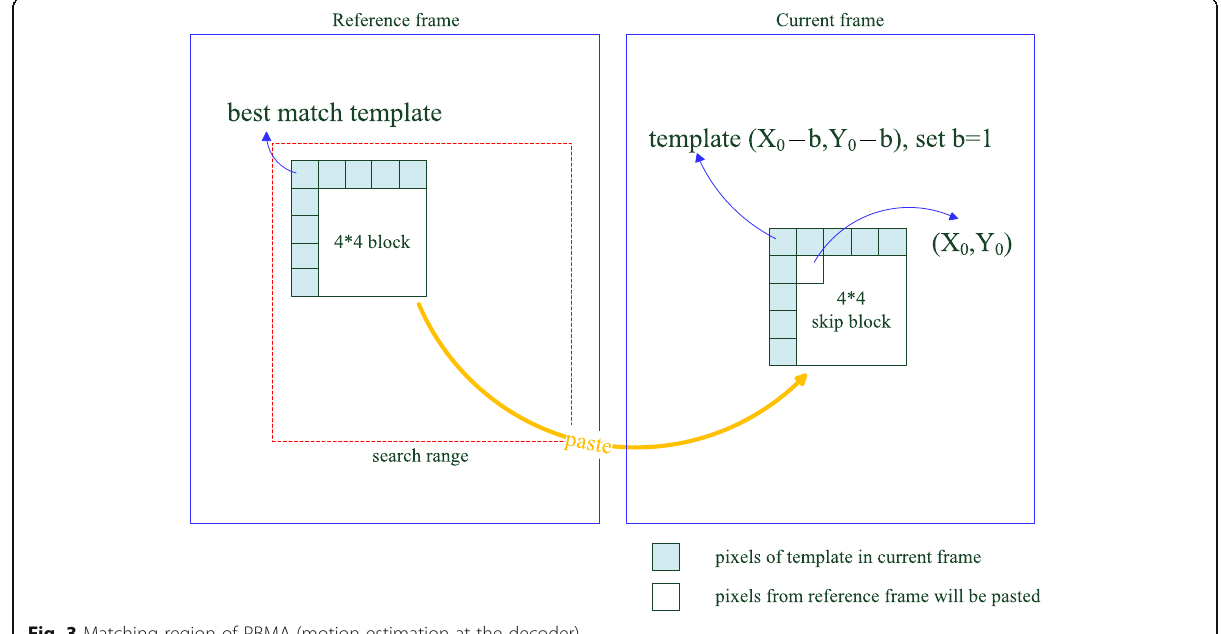
Fig. 3 Matching region of PBMA (motion estimation at the